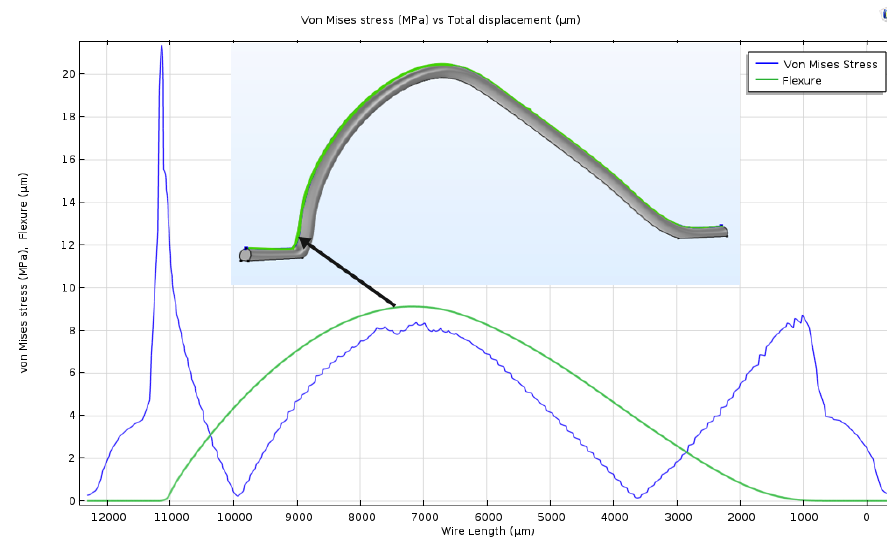
Figure 5. Vertical displacement and von Mises stress along the wire span under 10A dc